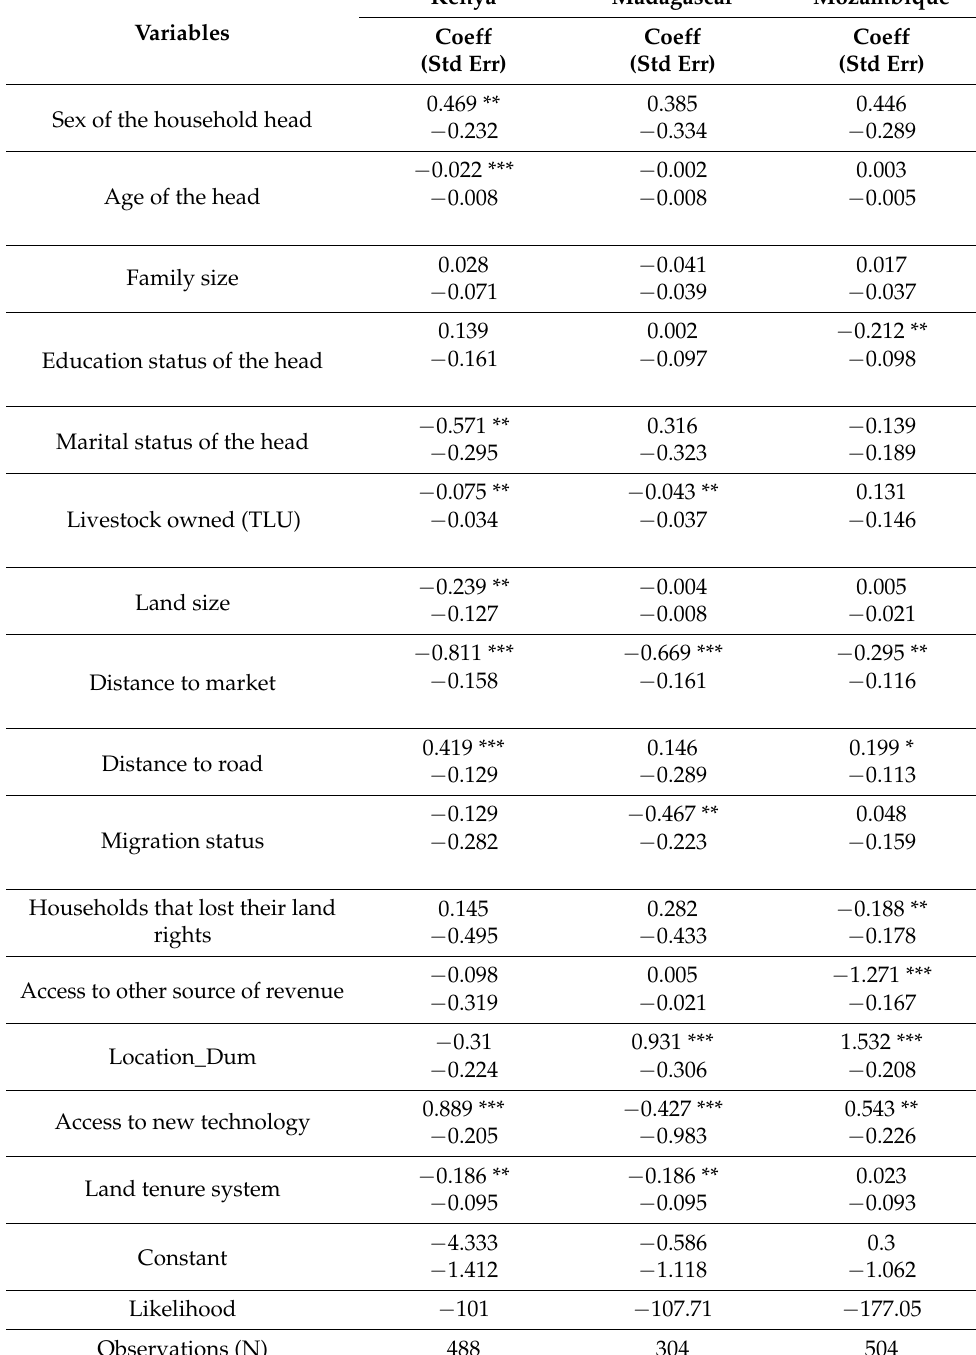
Table 7. Determinants of participation in